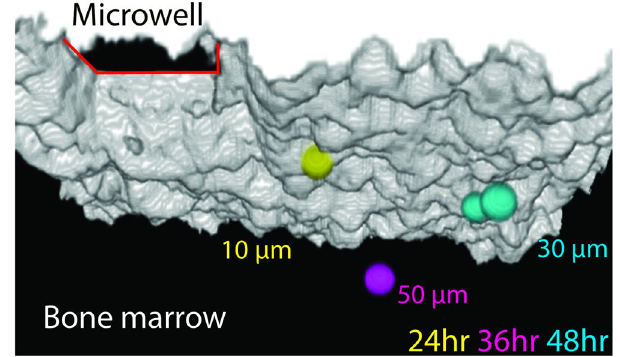
Figure 6. Monitoring engraftment after single HSC transplantation. Three-dimensional reconstruction from intravital imaging of the calvarial BM in the vicinity of the delivery site showing the delivered cell at 24 hours (yellow), 36 hours (magenta), and the outcome of the first HSC division at 48 hours (cyan). At different times, the cell is at a different distance from the endosteal surface (24 hrs: 10 μ m, 36 hrs: 50 μ m, and 48 hrs: 30 μ